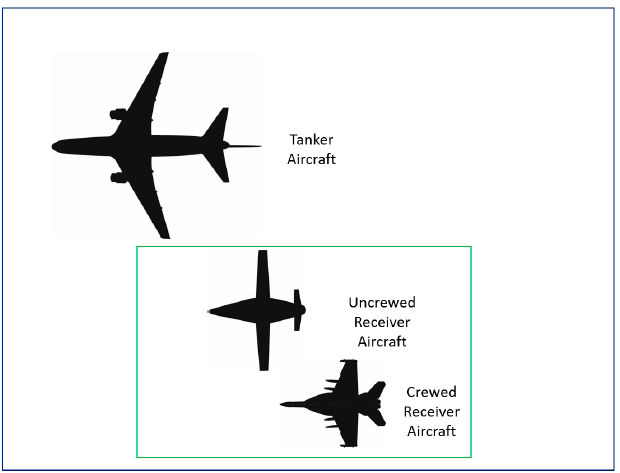
Figure 3. Visual depiction of left echelon formation (tanker at top and two receiving aircraft at bot ‐ tom).